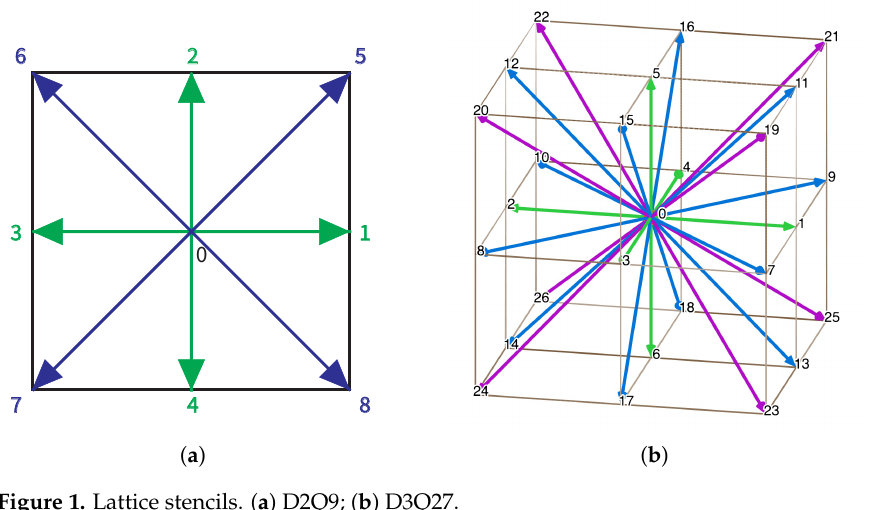
Figure 1. Lattice stencils. ( a ) D2Q9; ( b )